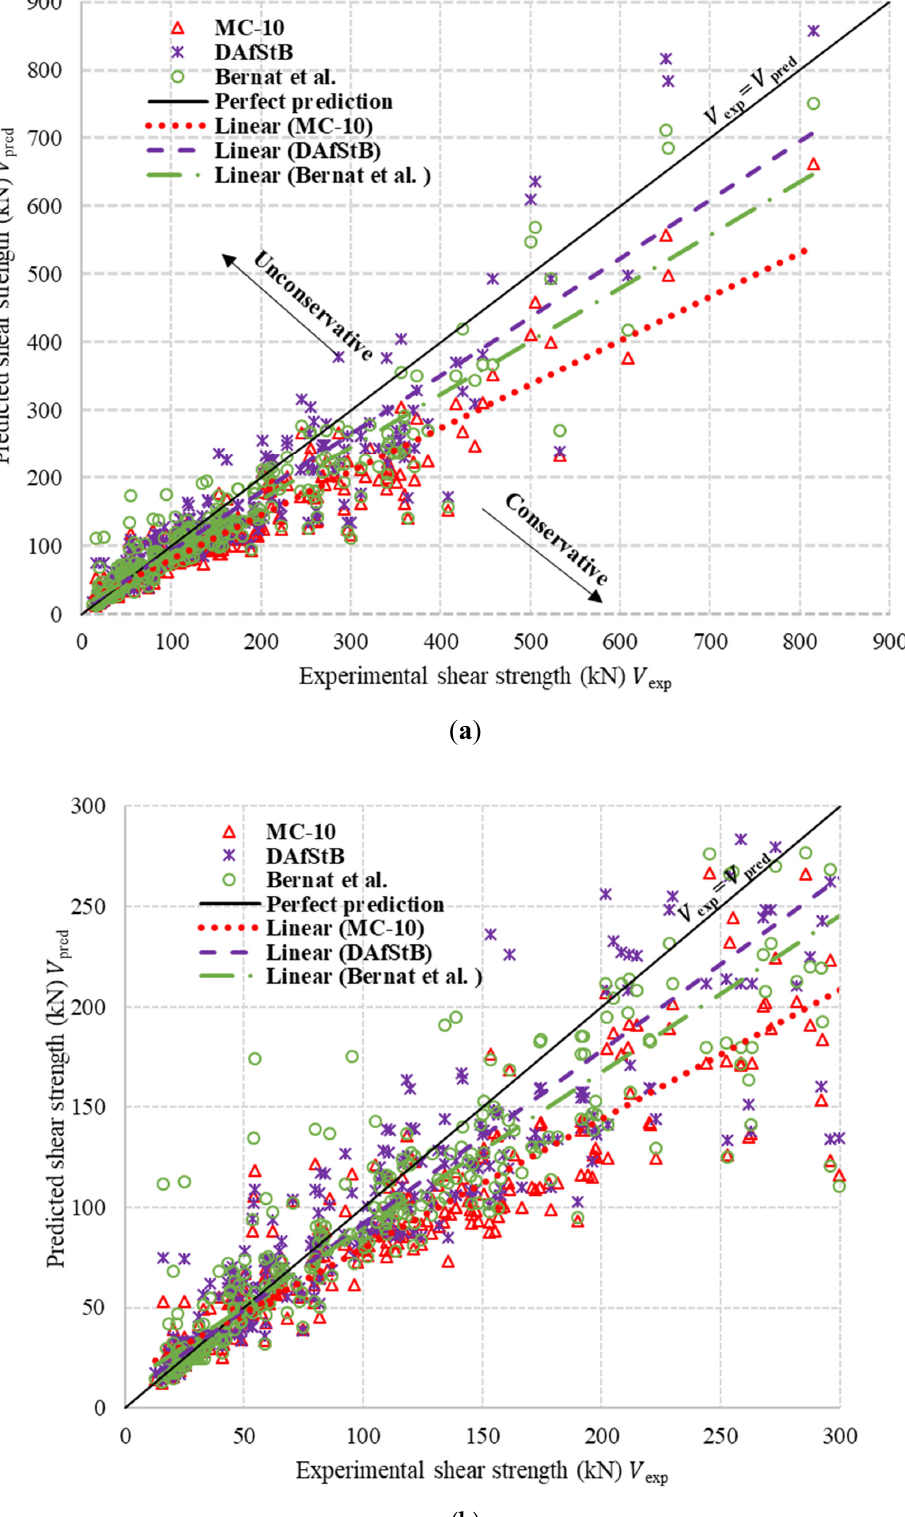
Figure 1. ( a ) Plot of the correlation between the experimentally observed shear strength V exp and mean shear resistance predictions V pred . ( b ) Plot of the correlation between the experimentally observed shear strength V exp and mean shear resistance predictions V pred (resistance up to 300 kN